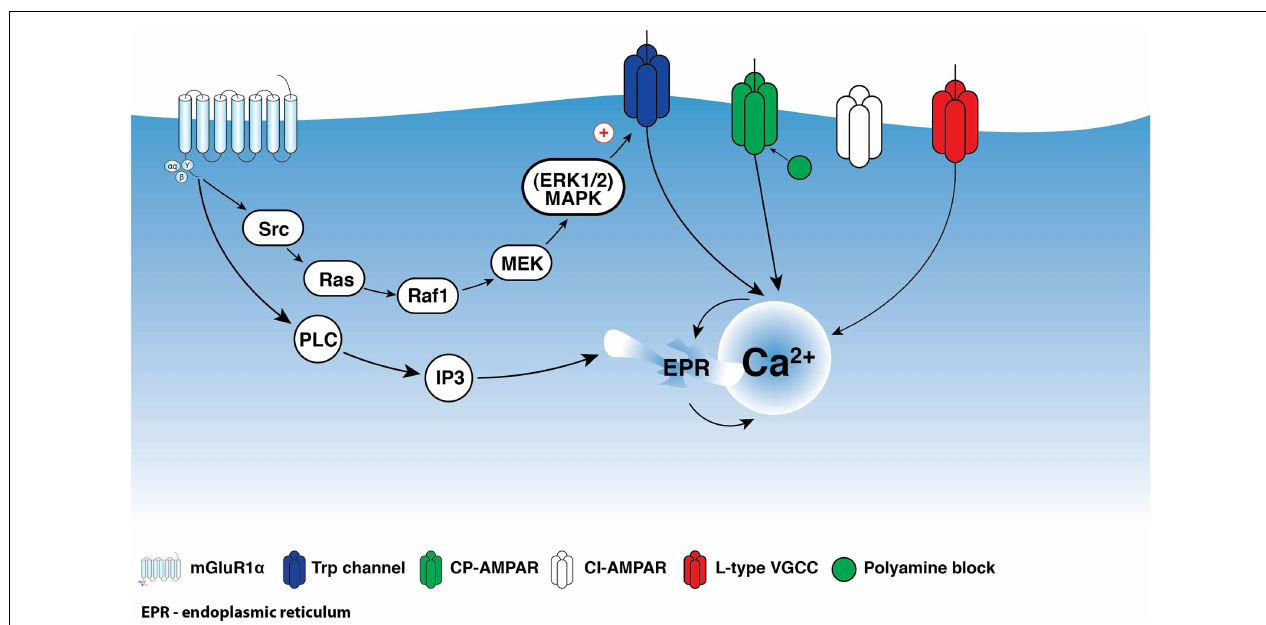
be involved in the regulation of Ca 2 + entry viaTRP channels, which together with intracellular release are necessary for the induction of Hebbian LTP. In addition, mGluR1 α activation together with Ca 2 + entry through CP-AMPARs appear to be involved in anti-Hebbian LTP